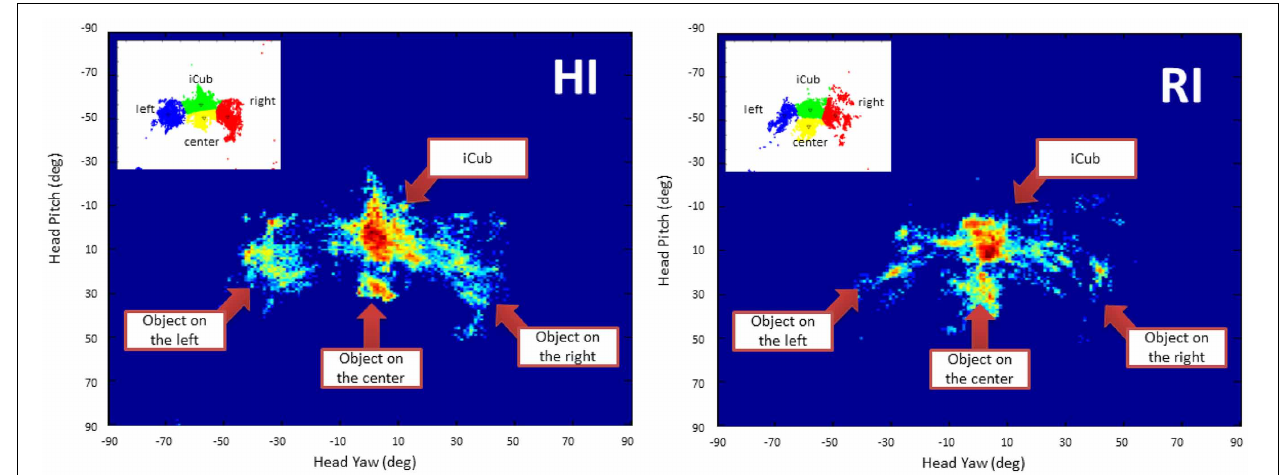
FIGURE 8 | Normalized gaze heat map of the human partners in the HI and RI groups. The plots show the points in the pitch-yaw space representing the gaze direction of the human partners during the interaction with the robot.